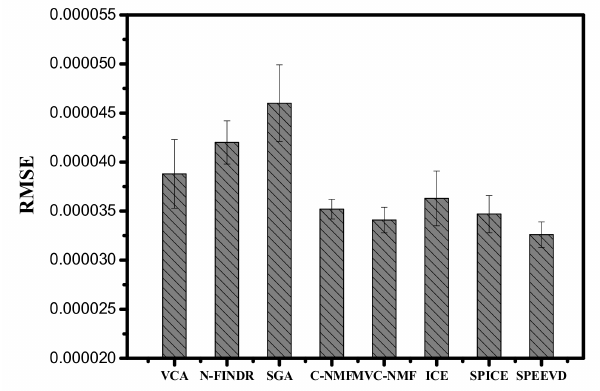
Figure 5. The average RMSEs of